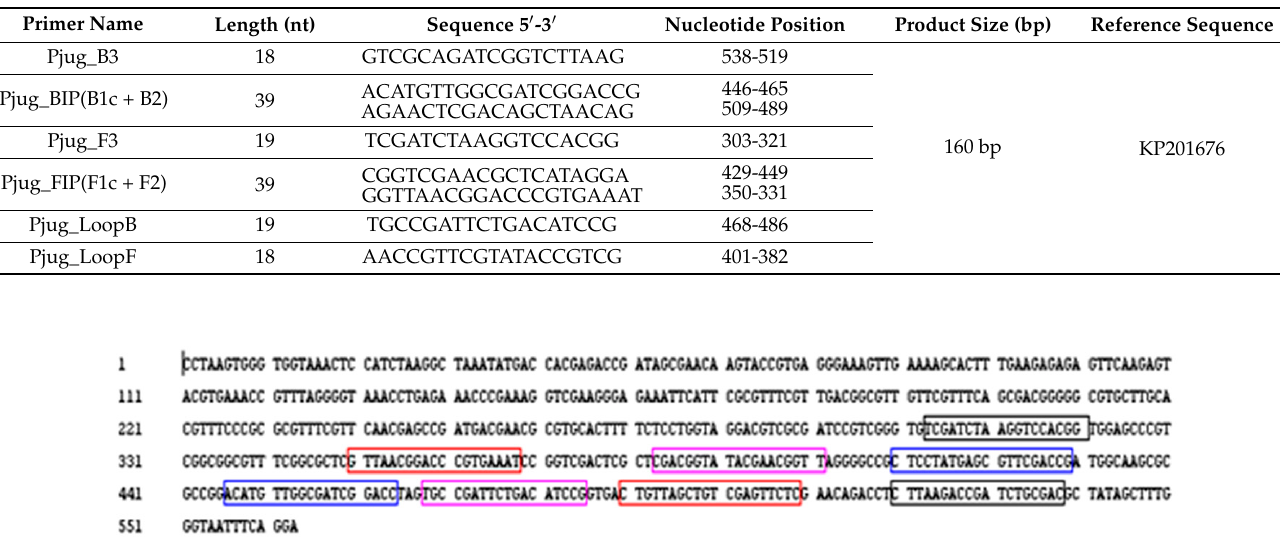
Table 5. LAMP primers designed to target WTB DNA. For each primer, the nucleotide position on the reference sequence is reported.